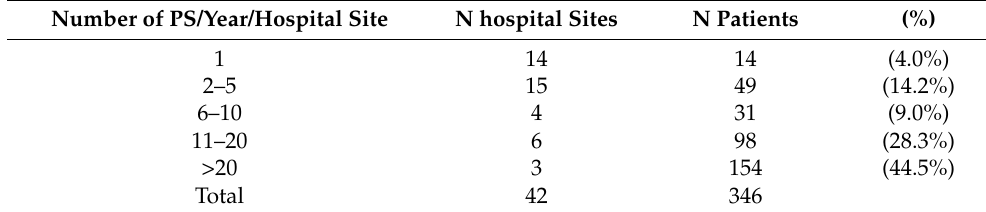
Table 4. Distribution of hospital sites and number of patients operated according to hospital pancre- atic surgery acts’ reference